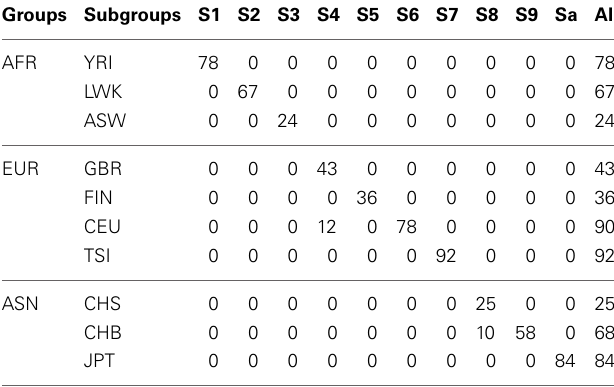
Table 5 | The numbers of subjects assigned to each of the 10 clusters based on the top 10 PCs using the unsupervised local scale spectral clustering algorithm.